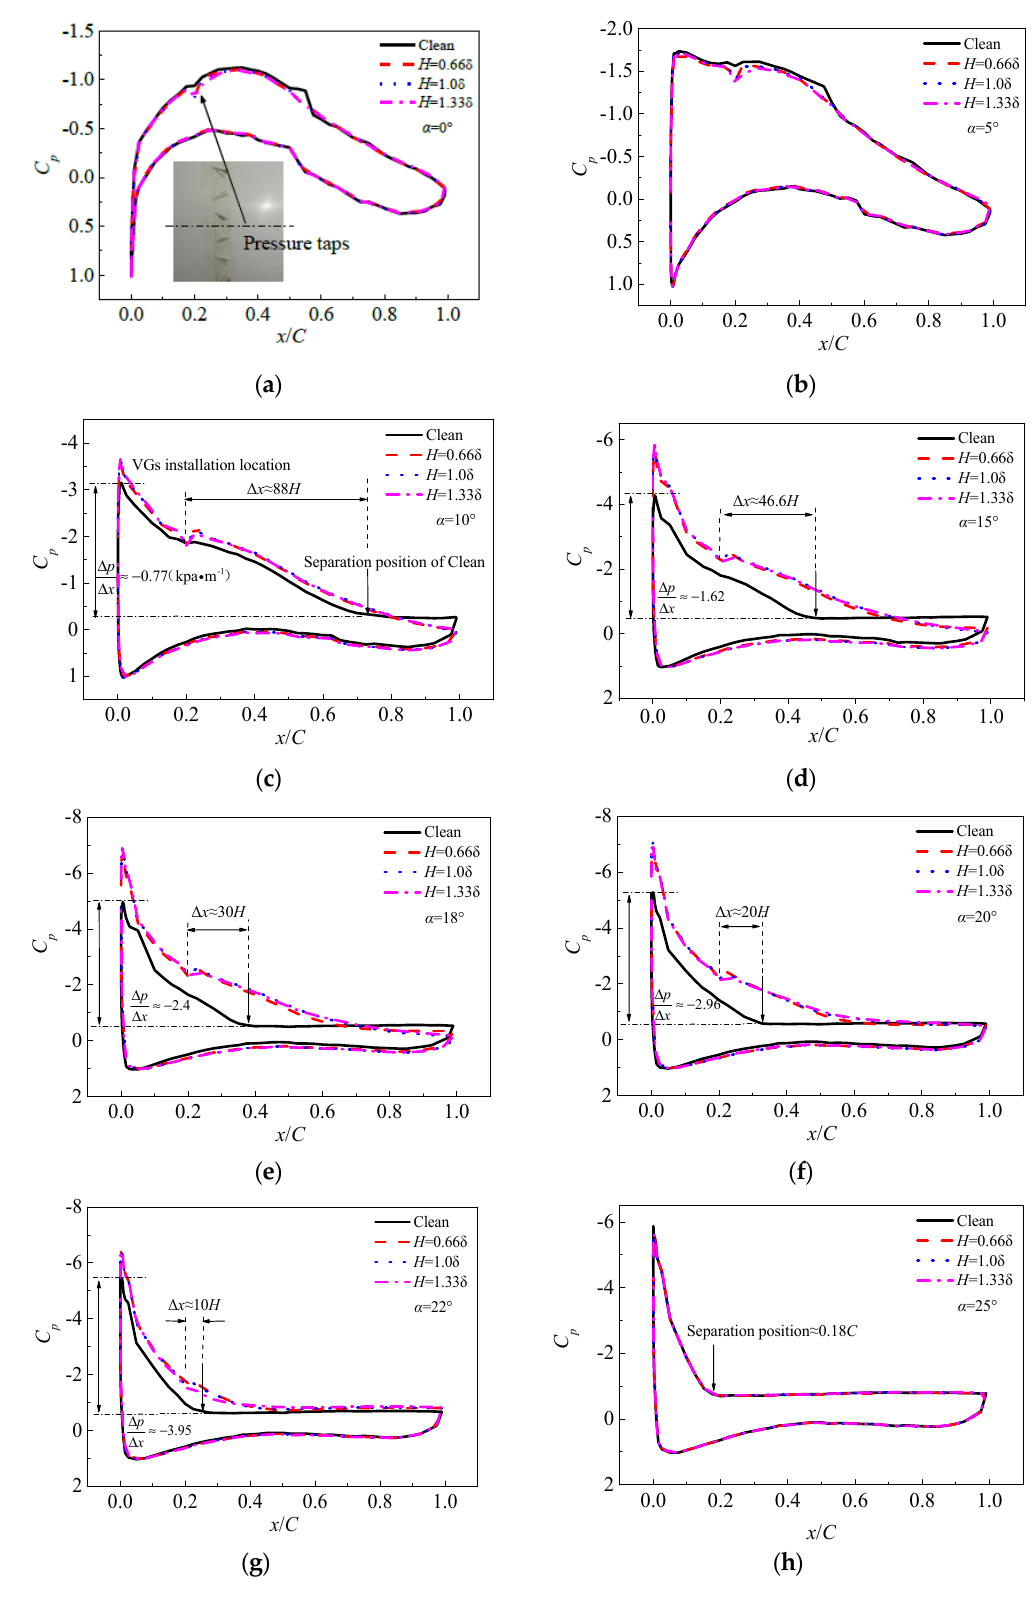
Figure 19. Distribution of C p on the airfoil surface. ( a ) α = 0°, ( b ) α = 5°, ( c ) α = 10°, ( d ) α = 15°, ( e ) α = 18°, ( f ) α = 20°, ( g ) α = 22°, ( h ) α = 25°.